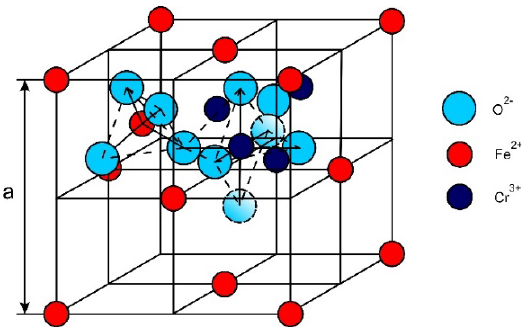
Figure 1. Unit cell of the FeCr 2 O 4 compound with a spinel structure. Ions in the quarter of the unit cell are shown.